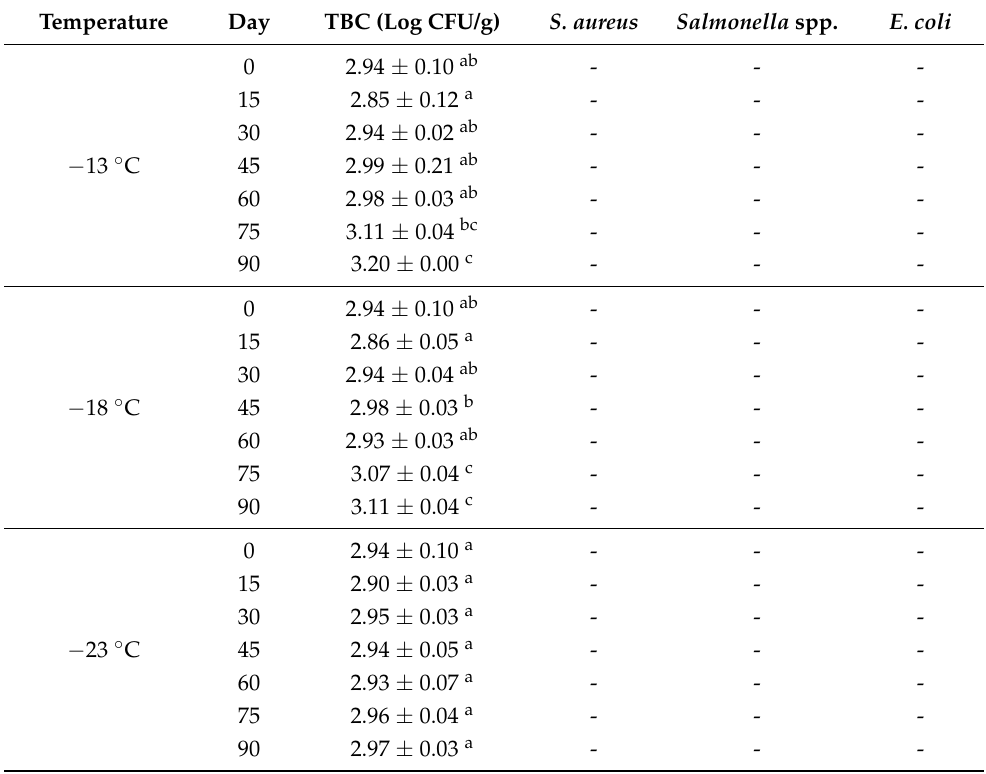
Table 10. TBC and microbiology of test seafood HMR products, consisting of a mixture of AMPS, CSM, and sauce, stored at different